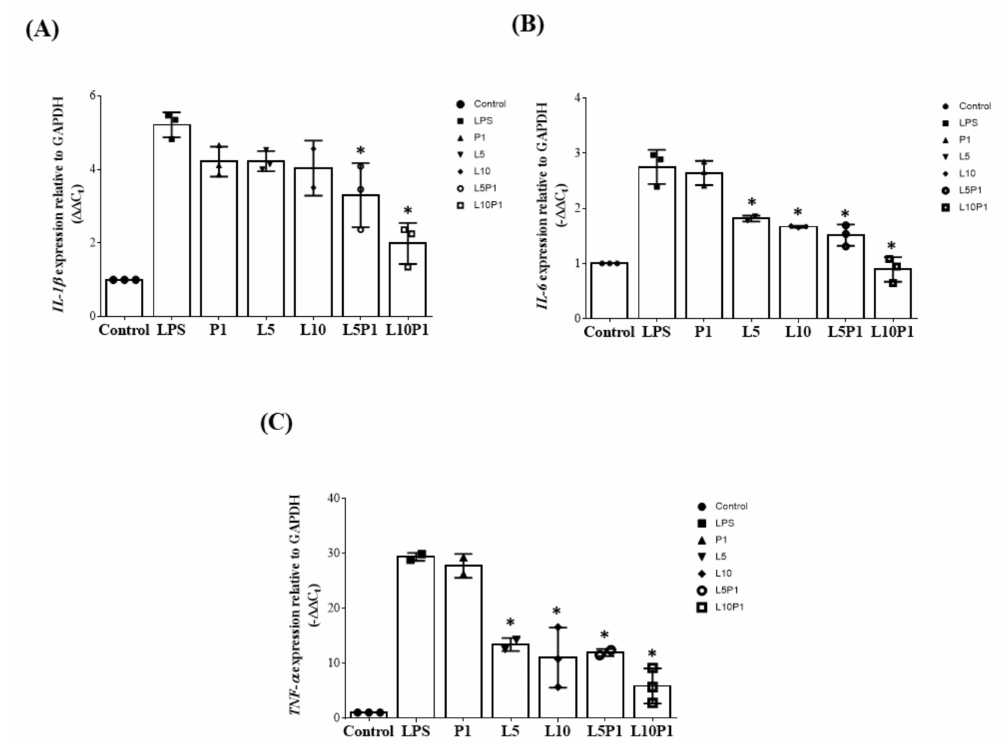
Figure 3. Expression of ( A ) IL-1 β , ( B ) IL-6, and ( C ) TNF α in HCE-2 upon LPS-induced inflammation (6 h) and treatment with various lutein/PVA formulations for 2 h. The control group consisted of cells without LPS treatment. Results are displayed as the fold increase compared to the expression in normal HCE-2. All groups were compared with the LPS group for statistical analysis; n = 3, (* p < 0.05). LPS: lipopolysaccharide; L5: 5 µ M lutein; L10: 10 µ M lutein; P1: 1%